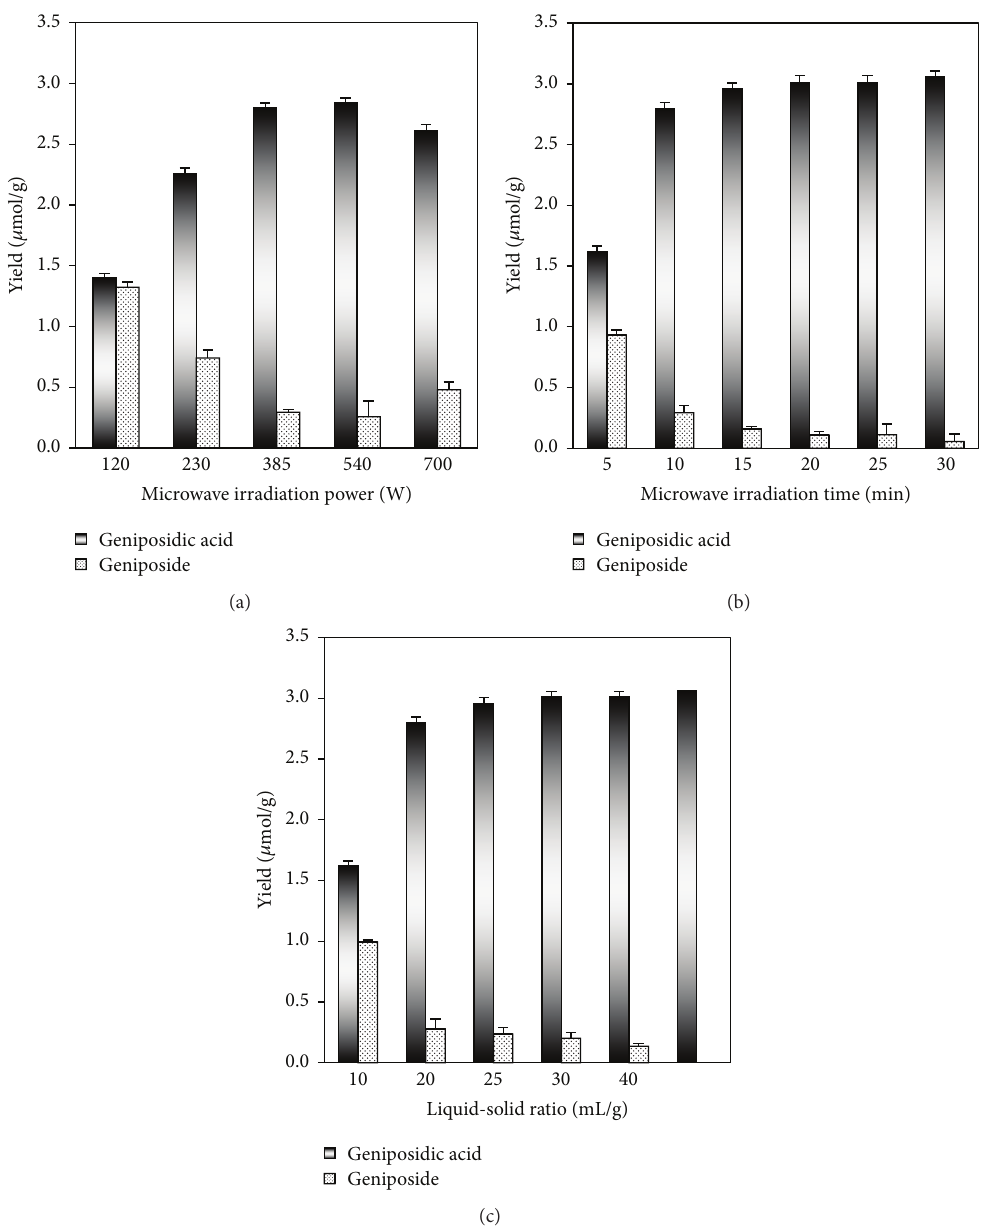
Figure 3: Effects of microwave irradiation power (a), microwave irradiation time (b), and liquid-solid ratio (c) on the yield of geniposidic